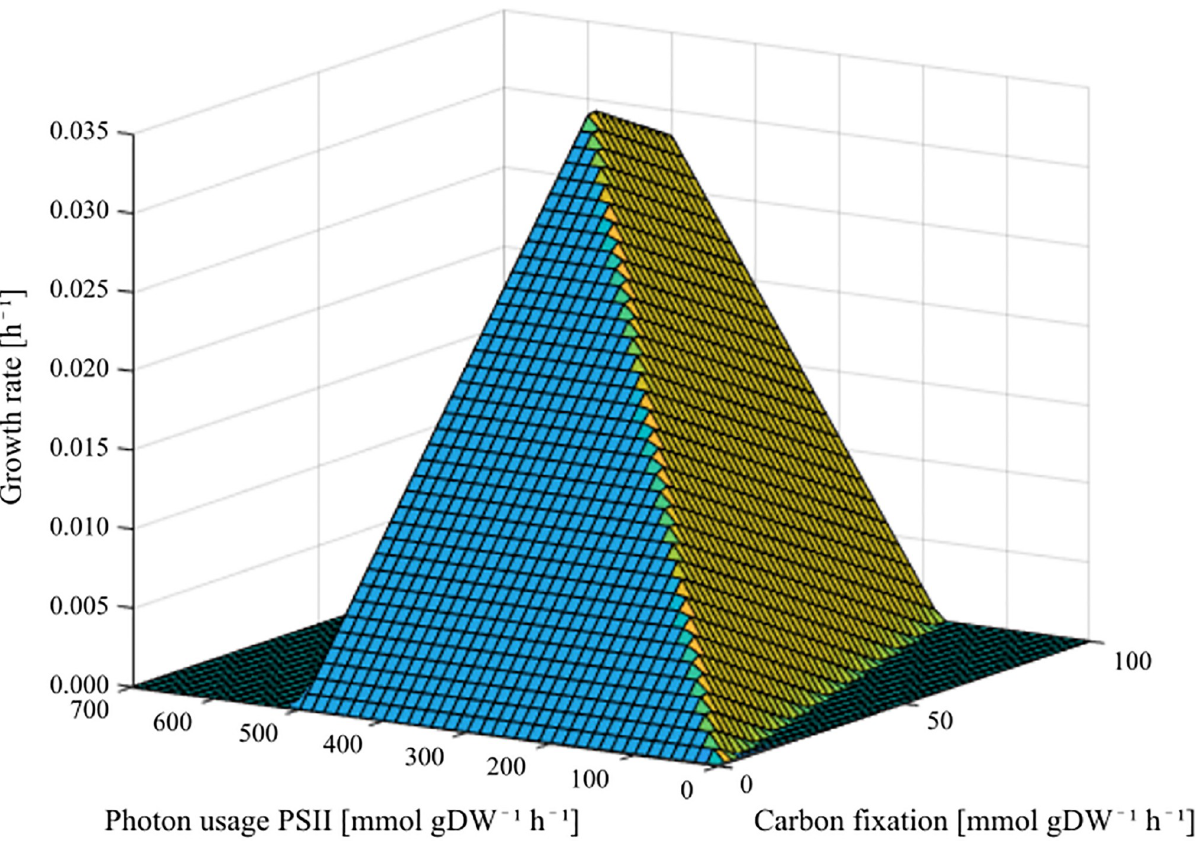
Fig 3. Phenotype phase plane showing how the fluxes of carbon fixation (NanoG0589) and photon usage by PSII (PSII_photon) affect the flux of the chloroplast biomass function.